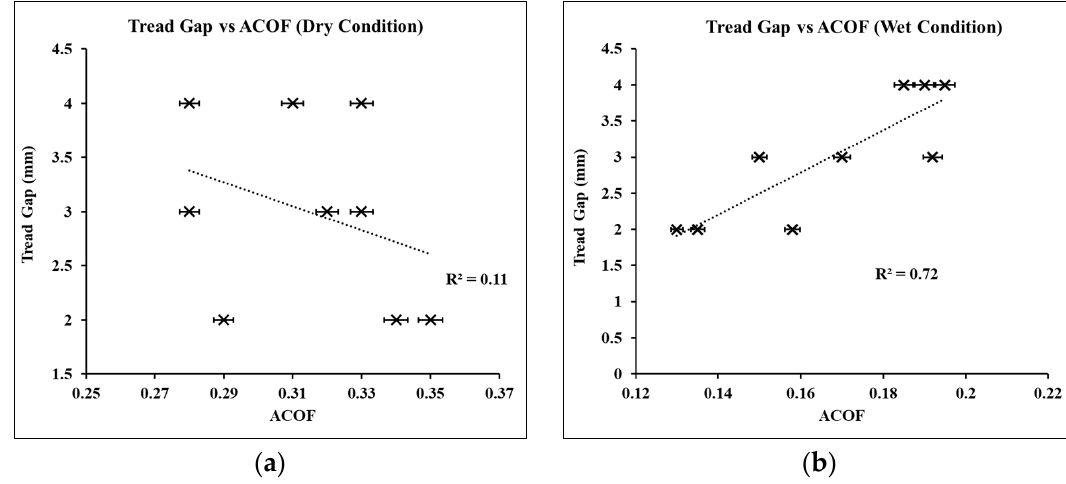
O9 Figure 7. Mass flow rates across the outsole treads due to wet slipping simulations. 3.3. Effect of Tread Parameters on Study Outcomes 3.3.1. Effect of Tread Gaps on ACOF, Fluid Pressure, and Flow Rate The effect of changing gaps (i.e., gap = 2 mm, 3 mm, and 4 mm) between the treads of the outsoles on friction was analyzed by quantifying the correlation between the gaps and the ACOF (Figure 8). In the dry slip-testing conditions, the gaps between the treads showed a weak correlation (R 2 = 0.11) with the ACOF, as the ACOF ranged widely without any particular trend (Figure 8a). On the contrary, in the wet slip-testing conditions, the